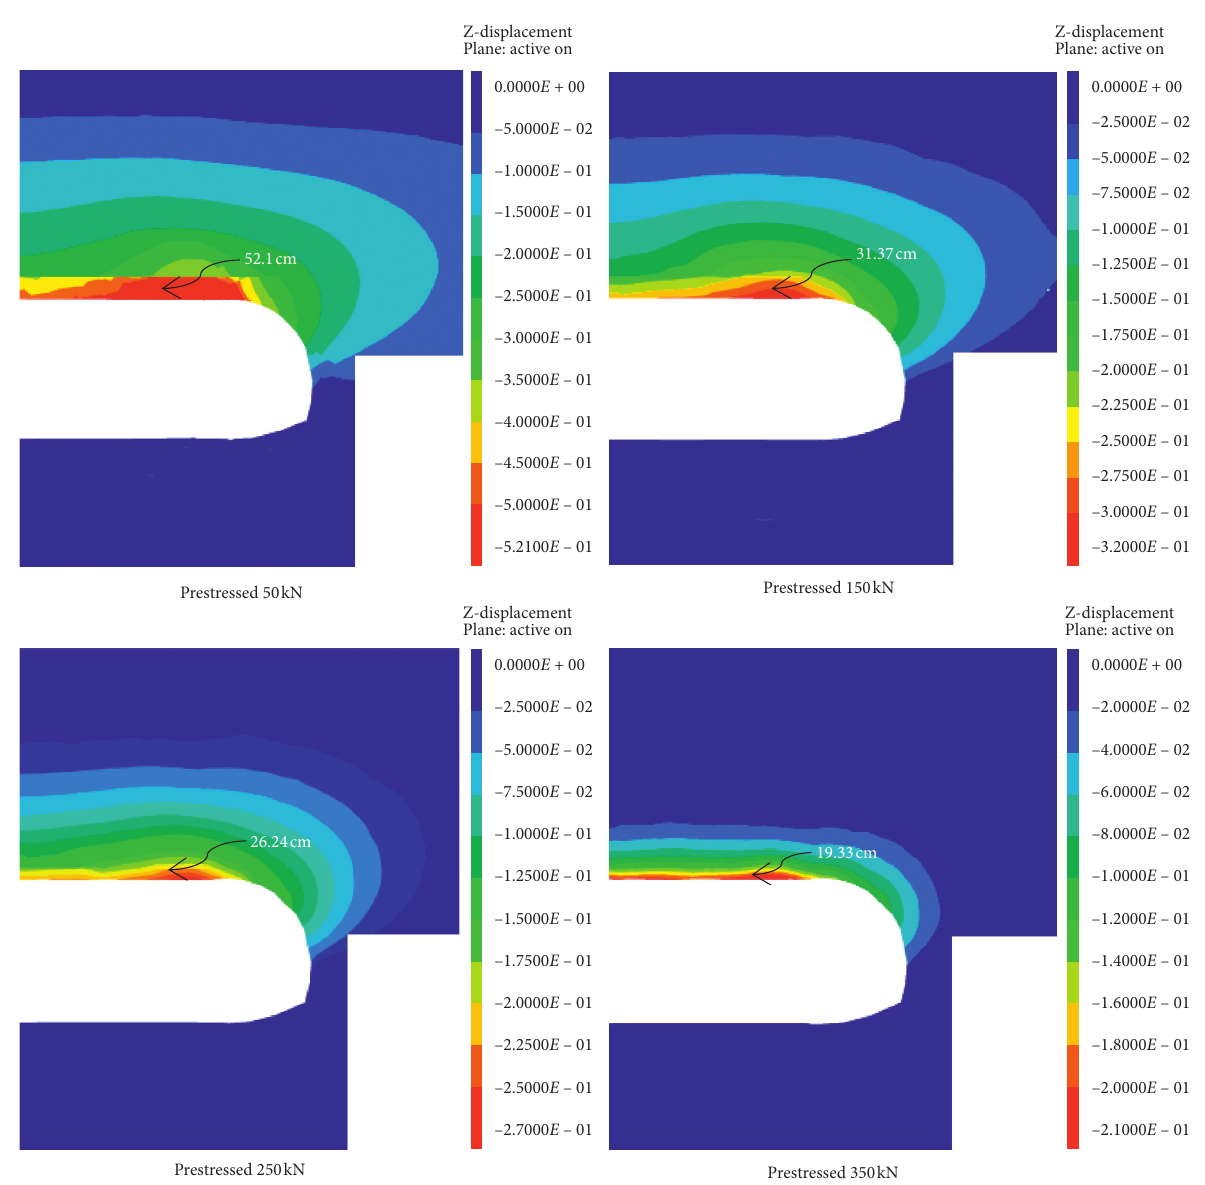
Figure 26: Subsidence characteristics under different prestressing (Section